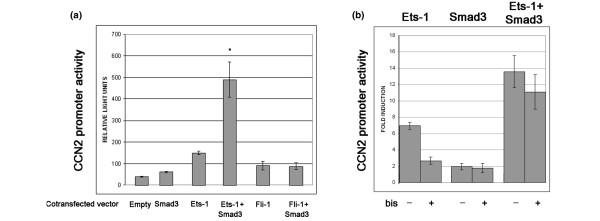
Ets-1 synergizes with Smad3 to activate the CCN2 promoter. (a) Ets-1, but not Fli-1, synergizes with Smad3 to activate the CCN2 promoter. A CCN2 promoter/reporter construct driven by nucleotides -805 to +17 of the CCN2 promoter was transfected into fibroblasts in the presence of empty expression vector or expression vector encoding Ets-1, Fli-1 or Smad3, as indicated. After a serum starvation step of 24 h, cells were incubated for an additional 24 h in the presence or absence of 4 ng/ml TGFβ1, as indicated. Co-transfection of Ets-1 and Smad3 (*p < 0.05), but not co-transfection of Fli-1 and Smad3, significantly potentiates activation of the CCN2 promoter in comparison with transfection of either Ets-1 or Fli-1 alone. Average ± standard deviation (N = 6) of a representative experiment is shown. Relative expression is shown. (b) Protein kinase C (PKC) is not required for Ets-1/Smad3 synergy. Addition of the general PKC inhibitor bisindolylmaleimide I (bis; 10 μM) blocks the ability of Ets-1 to activate the CCN2 promoter. Conversely, addition of bisindolylmaleimide I has no effect on the ability of Smad3 to activate the CCN2 promoter, or on the synergistic activation of the CCN2 promoter by both Smad 3 and Ets-1. Thus, the presence of excess Smad 3 allows Ets-1 to overcome a requirement for PKC, and permits the activation of the CCN2 promoter in the absence of PKC. Average ± standard deviation (N = 6) is shown. Fold induction by Ets-1, Smad3 or Ets-1/Smad3 is shown, relative to empty control expression vector. Reporter activity was adjusted for differences in transfection efficiencies among samples using a control β-galactosidase expression vector.